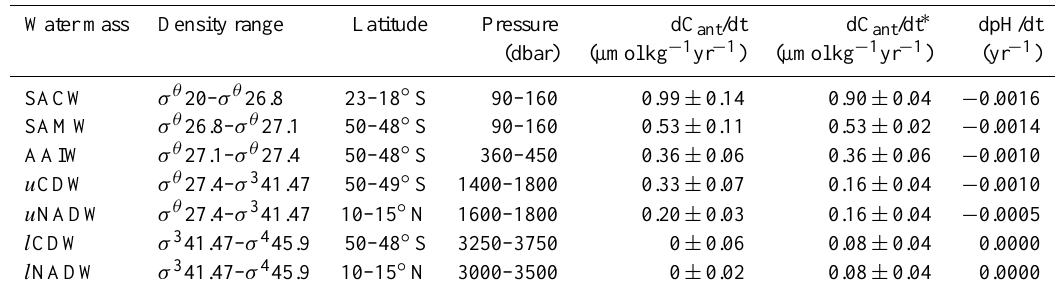
Figure 3. Section distributions of temperature ( ◦ C), salinity, AOU (µmolkg − 1 ) , silicate (µmolkg − 1 ) , A T (µmolkg − 1 ) and DIC (µmolkg − 1 ) from the GEOTRACES-NL (2010/2011) data set. Table 2. The calculated rates of increase in C ant and rates of decrease in pH along the section, listed per water mass. The identification criteria for each water mass are provided. Error represents 2 σ /N 0 . 5